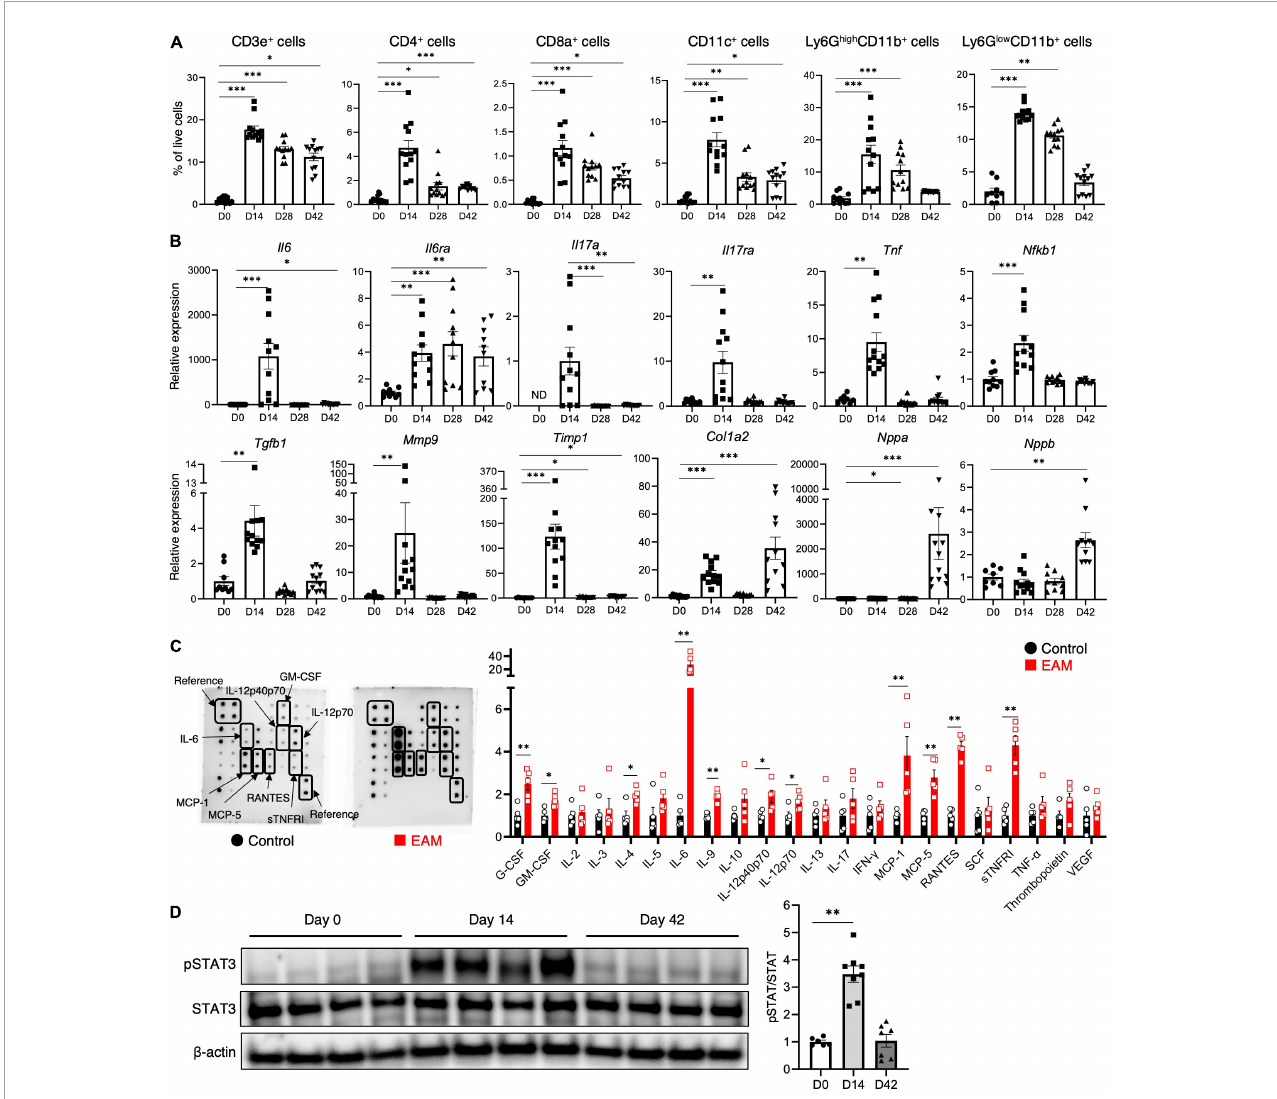
FIGURE2 Inflammatory cell infiltration, cytokine expression, and STAT3 activation in inflammatory atrial cardiomyopathy. (A) Flow cytometric analyses of the cardiac-infiltrating cells in the atria. (B) Expression of inflammation- and fibrosis-related genes in the atria. (C) Semi-quantitative membrane-based cytokine array analysis of the atrium performed on day 14. The bar graph shows the signal intensity of each cytokine when the control was set to 1. (D) Western blot analysis of the atrium. The bar graph shows the densitometric ratio of phosphorylated STAT3 (pSTAT3) to total STAT3. The results are presented as the mean ± SEM. ∗ P < 0.05, ∗∗ P < 0.01, ∗∗∗ P < 0.001 using the Mann–Whitney U test, and Kruskal–Wallis test with Dunn’s test. STAT3, signal transducer and activator of transcription 3; SEM, standard error of the